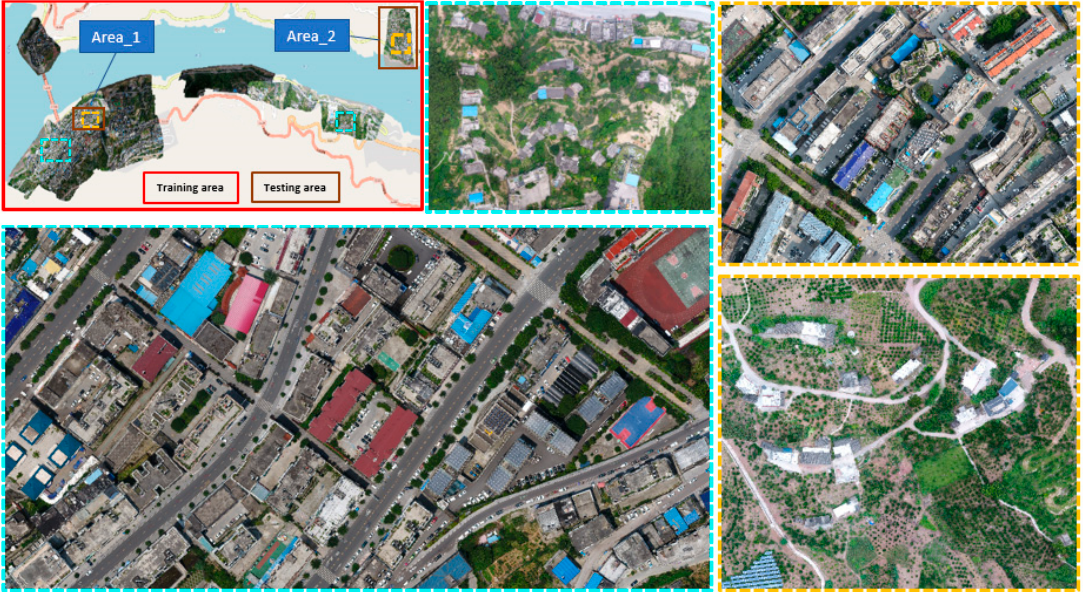
Figure 1. The study area; outer large red box in top left shows the entire study area; enlarged cyan boxes refers to training set area and yellow boxes are two testing areas.